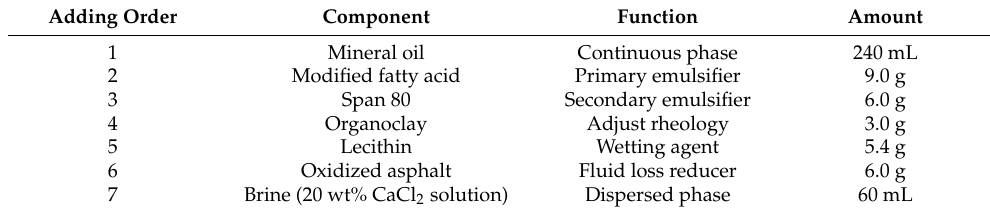
Table 3. Formulation of oil-based drilling